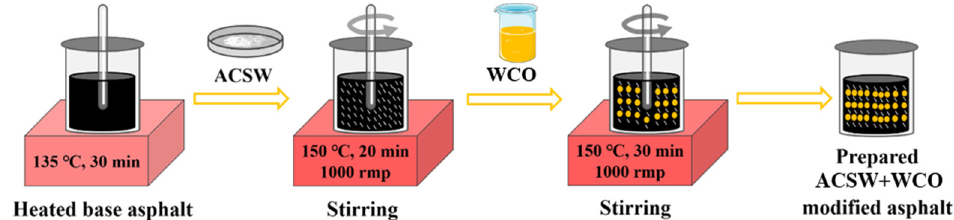
Figure 1. Flow chart of the compound-modi fi ed asphalt preparation.